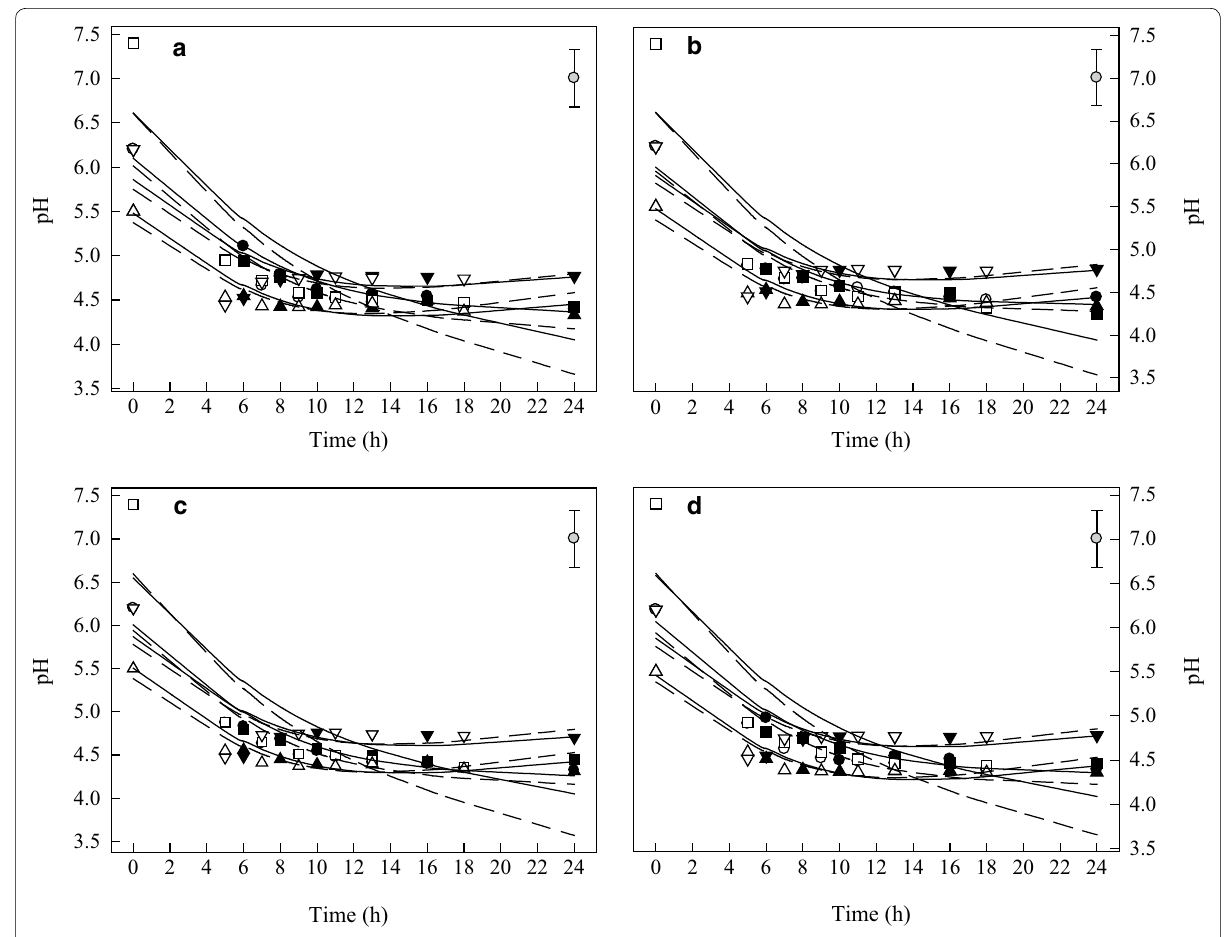
Fig. 6 pH changes of Lactobacillus curvatus (Arla-10) ( a ), Enterococcus faecium (JFR-1) ( b ), Lactobacillus paracasei subsp. paracasei (JFR-5) ( c ), and Streptococcus thermophilus (TSB-8) ( d ) grown under different growth conditions. ( ● ) MRS, pH 6.2, 37 °C; ( ○ ) MRS, pH 6.2, 44 °C; ( ■ ) MRS, pH 7.4, 37 °C; ( □ ) MRS, pH 7.4, 44 °C; ( ▲ ) BHI, pH 5.5, 37 °C; (Δ) BHI, pH 5.5, 44 °C; ( ▼ ) BHI, pH 6.2, 37 °C; ( ▽ ) BHI, pH 6.2, 44 °C. The experimental data were fitted to the logistic model. The vertical bar represents standard errors of the